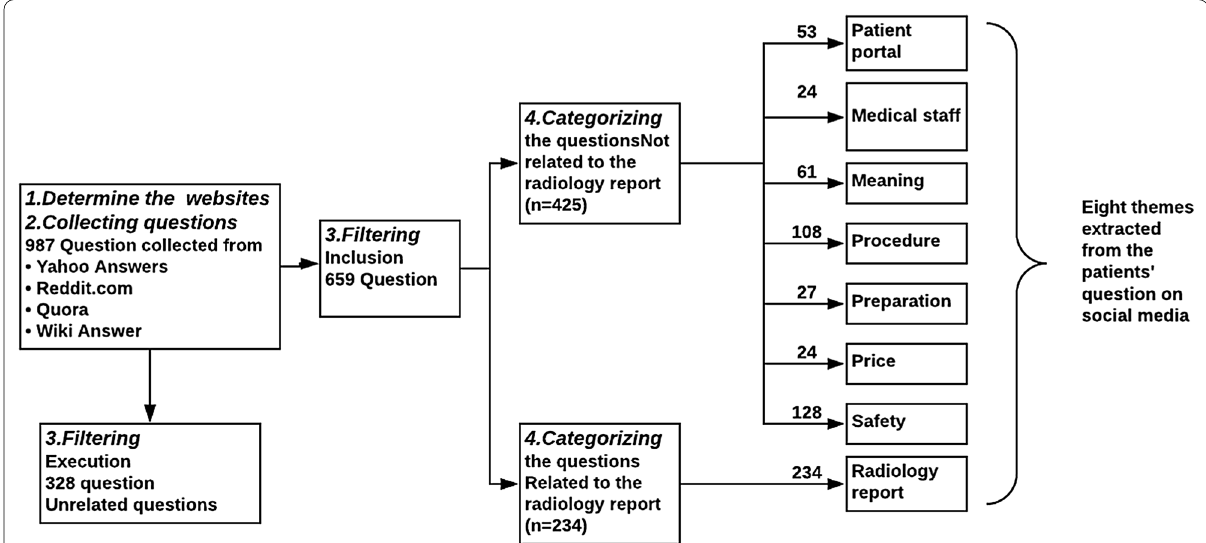
Fig. 2 Filtering the questions and creating the eight